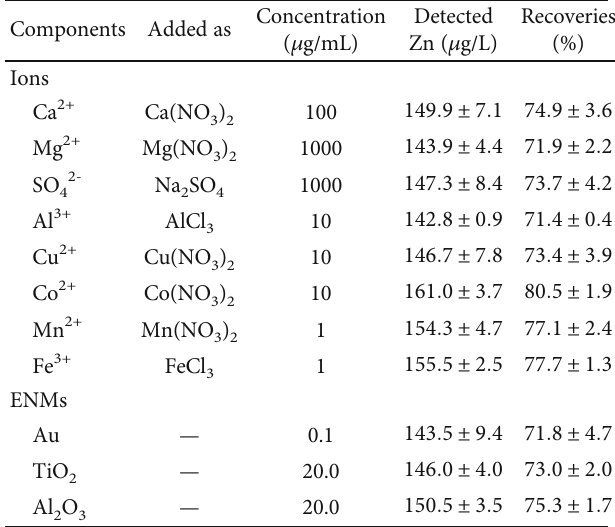
Table 4: Potential interfering ions and ENMs on the recoveries of ZnONPs ( n = 3 ).